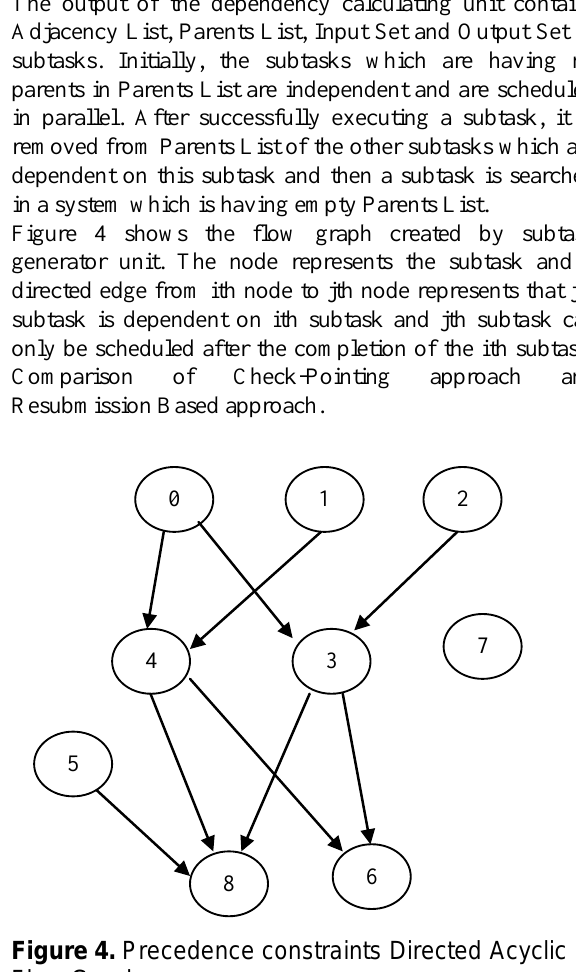
Figure 5. Number of job success for different values of budget